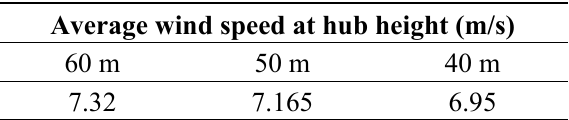
Table 3. Wind turbine experimental data during the month of